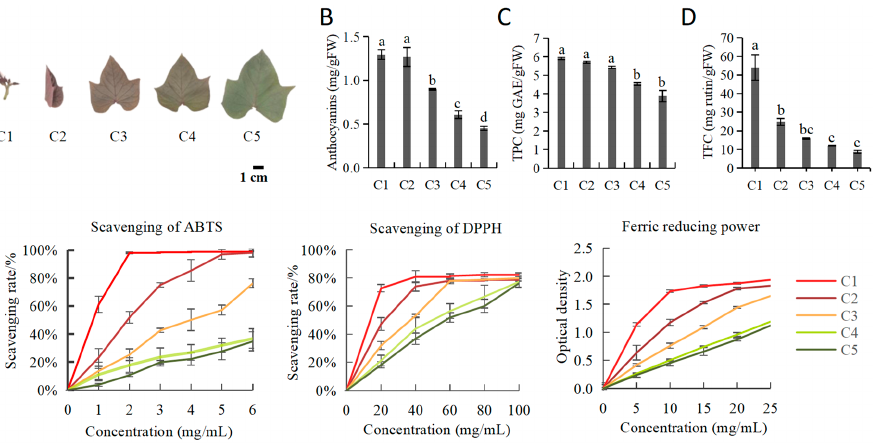
Figure 1. The contents of anthocyanins, total phenolics, total flavonoids, and antioxidant abilities for the five leaf stages of “Chuanshan Zi”. ( A ) The five leaf developmental stages from C1 to C5. The contents of ( B ) anthocyanins, ( C ) total phenolics (TPC), ( D ) total flavonoids (TFC) across the five leaf stages. ( E ) Antioxidant activities indicated by ABTS/DPPH radical-scavenging activity and ferric reducing power. All values are expressed as means ± SE, n = 3. Different letters mean significant differences ( p < 0.05).